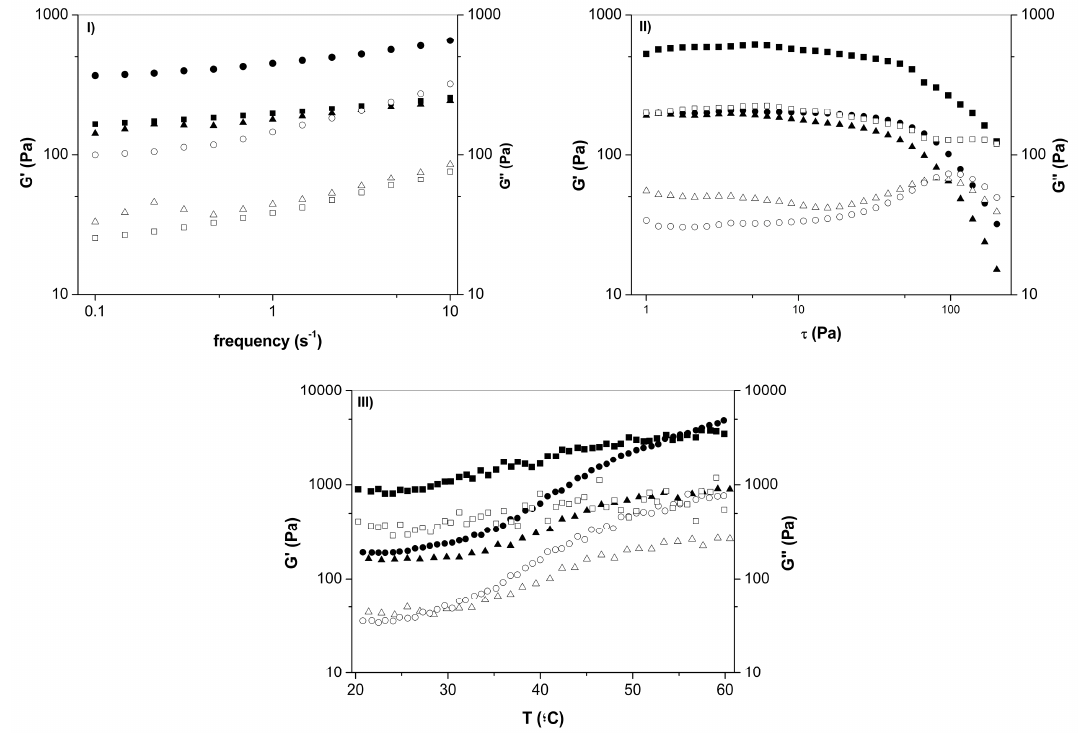
Figure 6. Rheological properties of PVA/CS/MA- β -CD composite hydrogels, which presented high ( ● ,o), intermediate ( ▪ , ), and low( ▲ , ) swelling degree, respectively, determined through oscillatory measurements, oscillatory frequency sweep (0.1–10 Hz; I ), amplitude sweep(1–200 Pa; II ), and as a function of temperature (20–60 °C; III ).